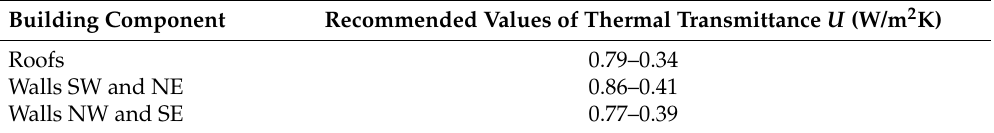
Table 15. Threshold values of thermal transmittance